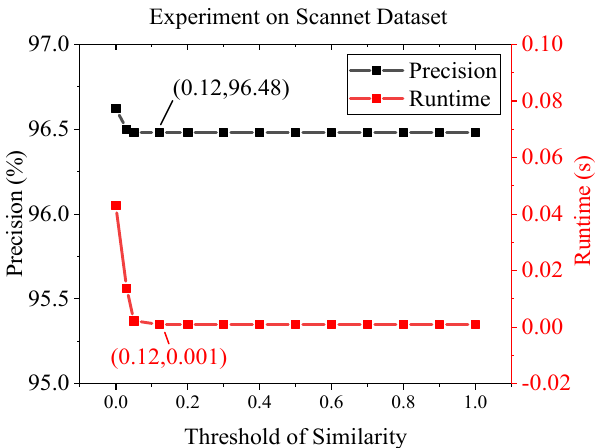
Figure 10. The impact of threshold of similarity on matching precision and average runtime on the Scannet dataset.